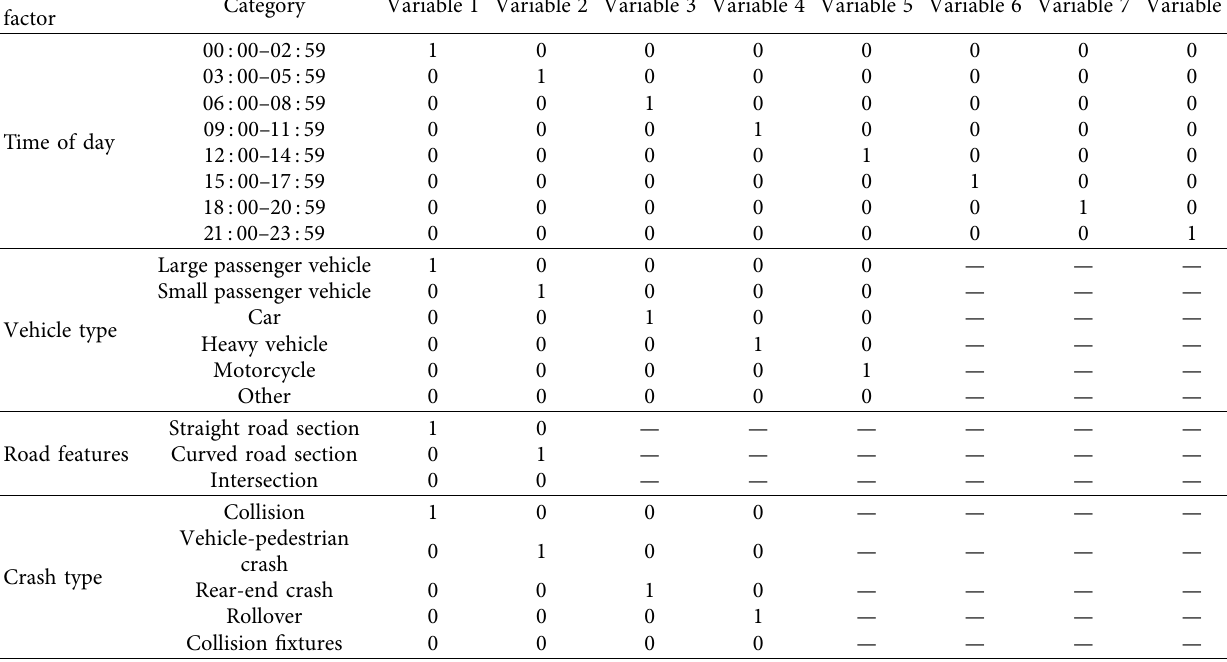
Table 4: Assign transform of dummy variables.